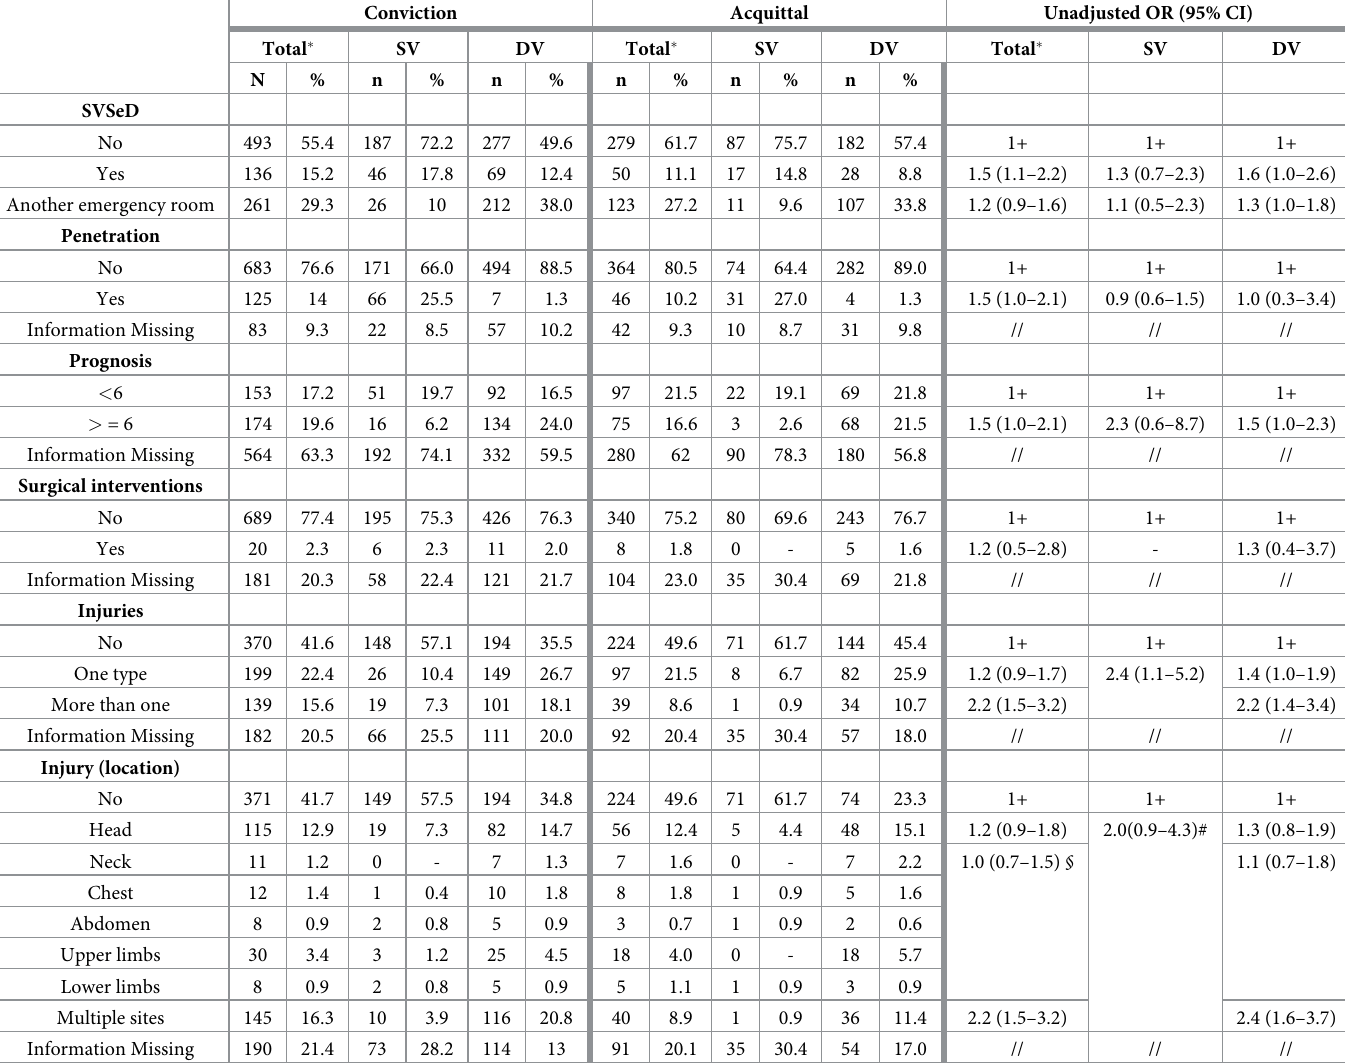
Table 6. Distribution of medical